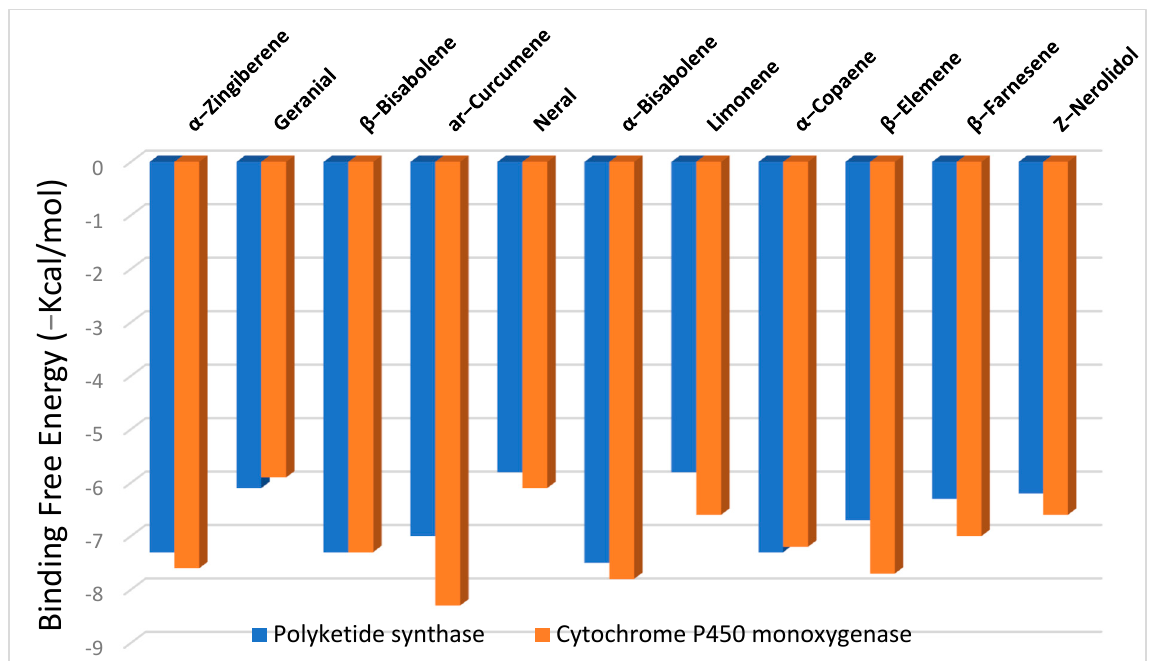
Figure 2. The binding free energy values were calculated by the molecular docking of significant constituents in ginger essential oil as ligands with polyketide synthase and cytochrome P450 monooxygenase.